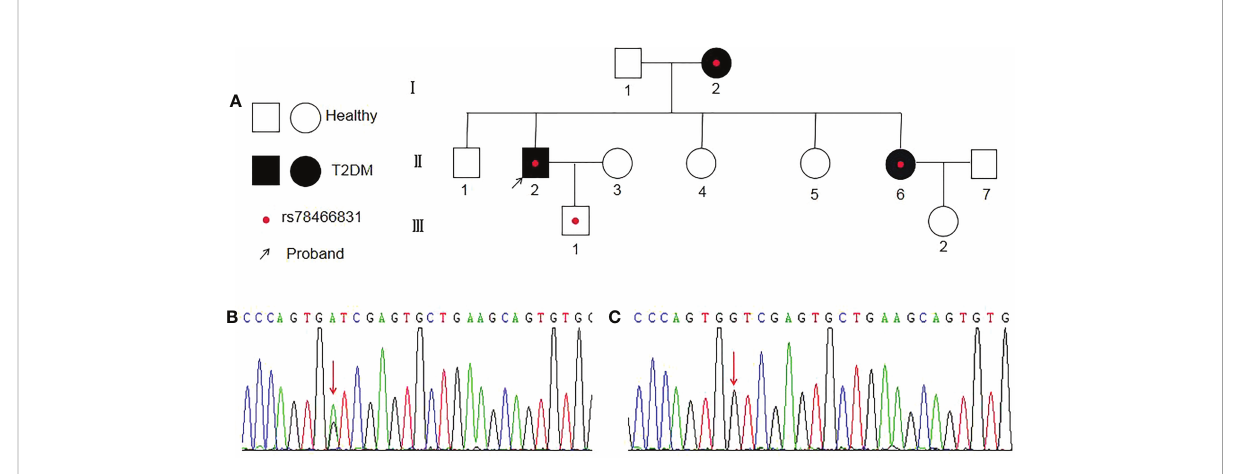
FIGURE 1 Diagram of a family with rs78466831. (A) Proband is indicated with an arrow. ◯ females; □ males; ● with rs78466831. (B) Single-base substitution mutation (rs78466831) is indicated with a red arrow. (C) Normal base (red